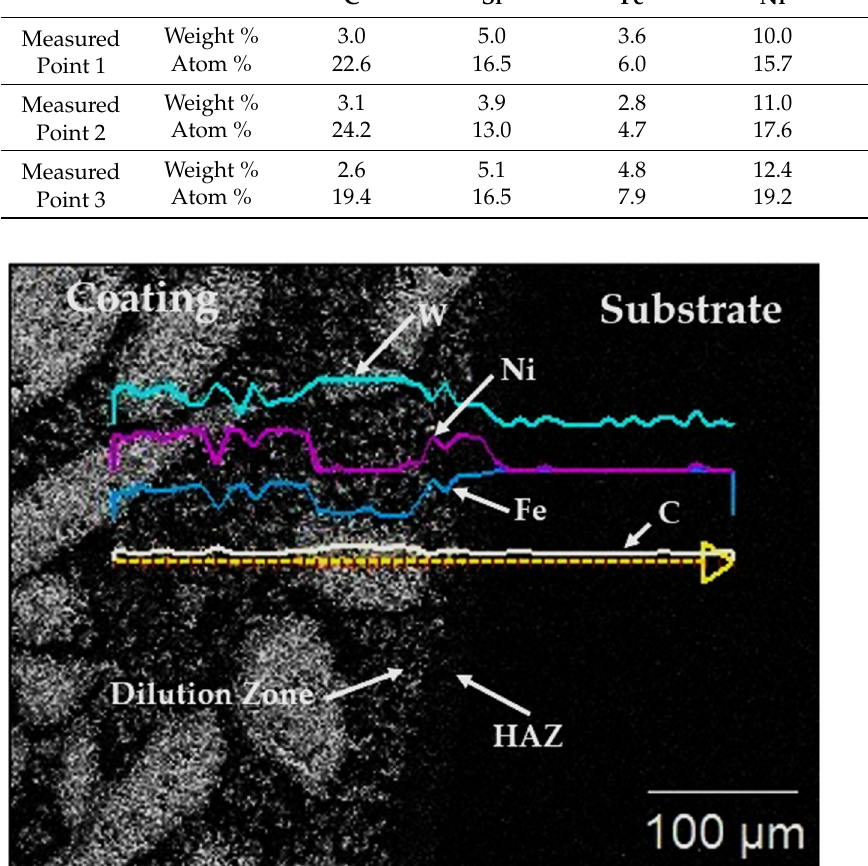
Figure 11. SEM image of the coating-substrate interface of sample 3-PE, showing the dilution zone, HAZ and the diffusion gradients of the chemical components involved in the interface adhesion between the coating and the surface.